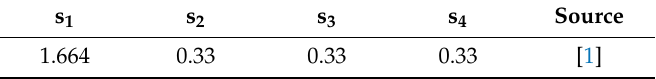
Table 2. Sherwood correlations for di ff erent Reynolds